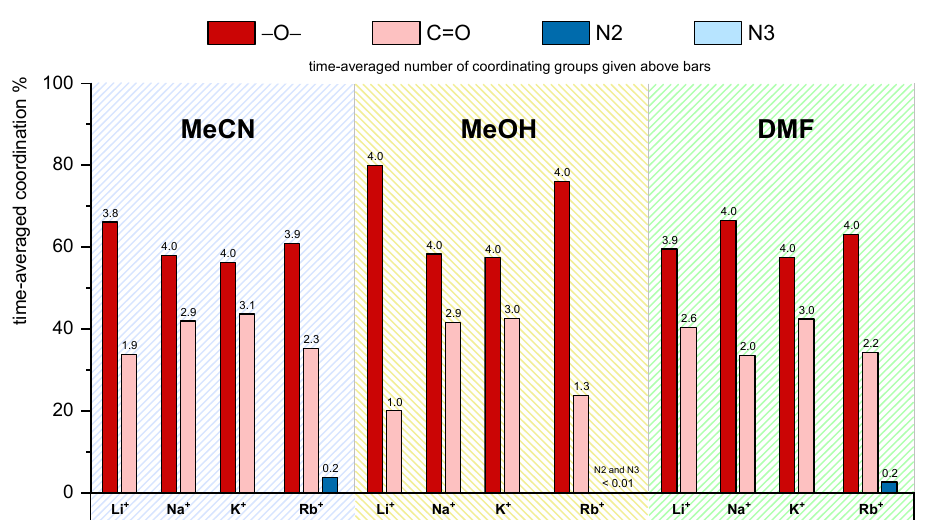
Figure 7. Time-averaged percentage and number of cation-coordinating groups of L in different solvents obtained by MD simulations.